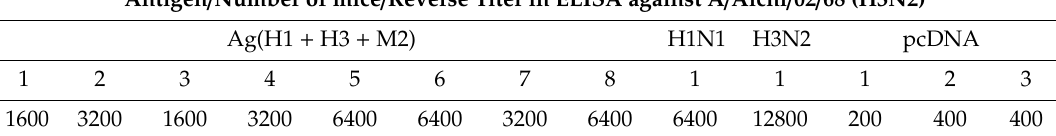
Table 3. Titers of anti-influenza virus antibodies assessed with ELISA in immunized mice sera.